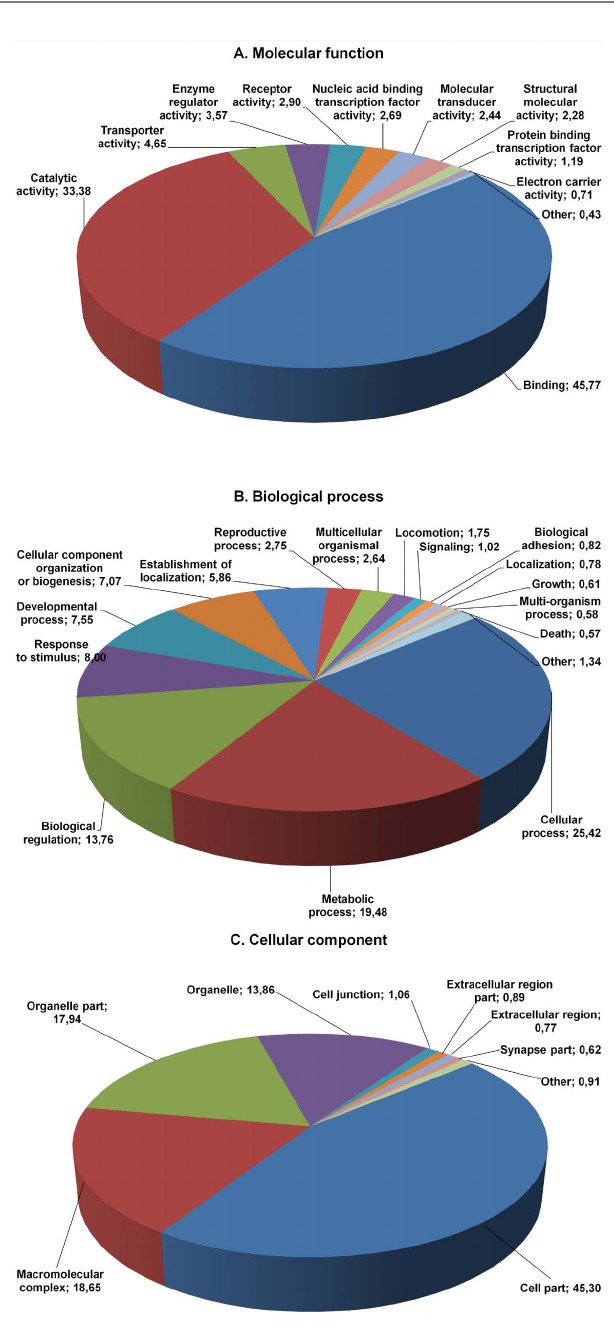
Figure 3. Gene ontology distribution of the MEET data set. GO term distribution, level 2, of our data set derived from the blast2go analysis of the FastAnnotator annotation pipeline. Percentages are indicated after each GO